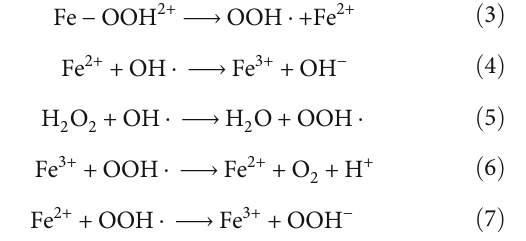
Figure 8: TEM images of calcined MNZ/Fe at 700 ° C: (a) scale of 10nm, (b) scale of 20nm, and (c) scale of